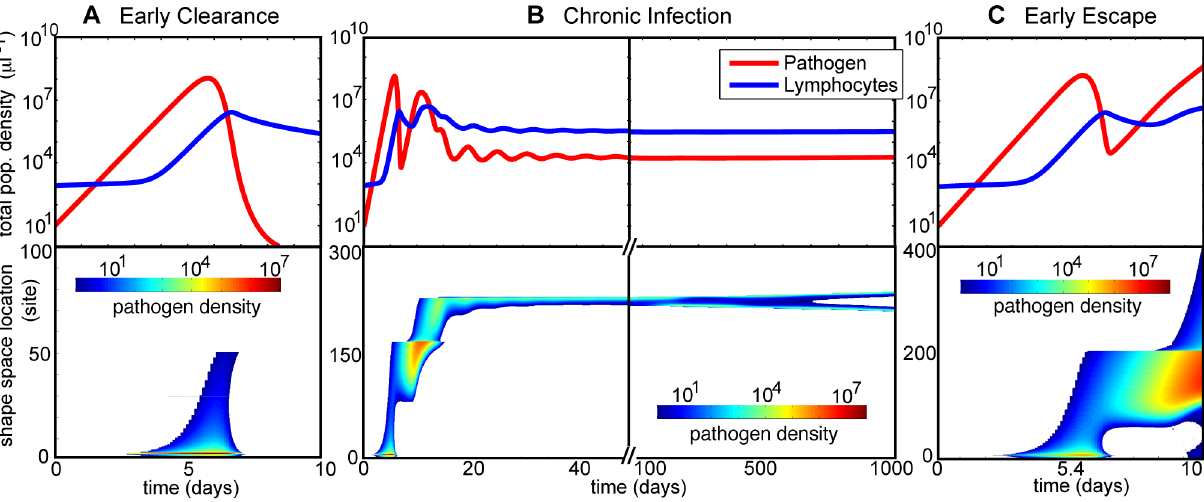
Figure 2. Examples of three of the four distinct types of infection observed in the deterministic model. (The case of sterilizing immunity is not shown.) The total population densities of both pathogens and T-cells (top panels), as well as the shape space distribution of the pathogens (bottom panels), are plotted over time for each infection. A. Early clearance after the acute phase of infection ( m ~ 1 | 10 (base { 5 : cycle) { 1 , b ~ 36 sites ). B.